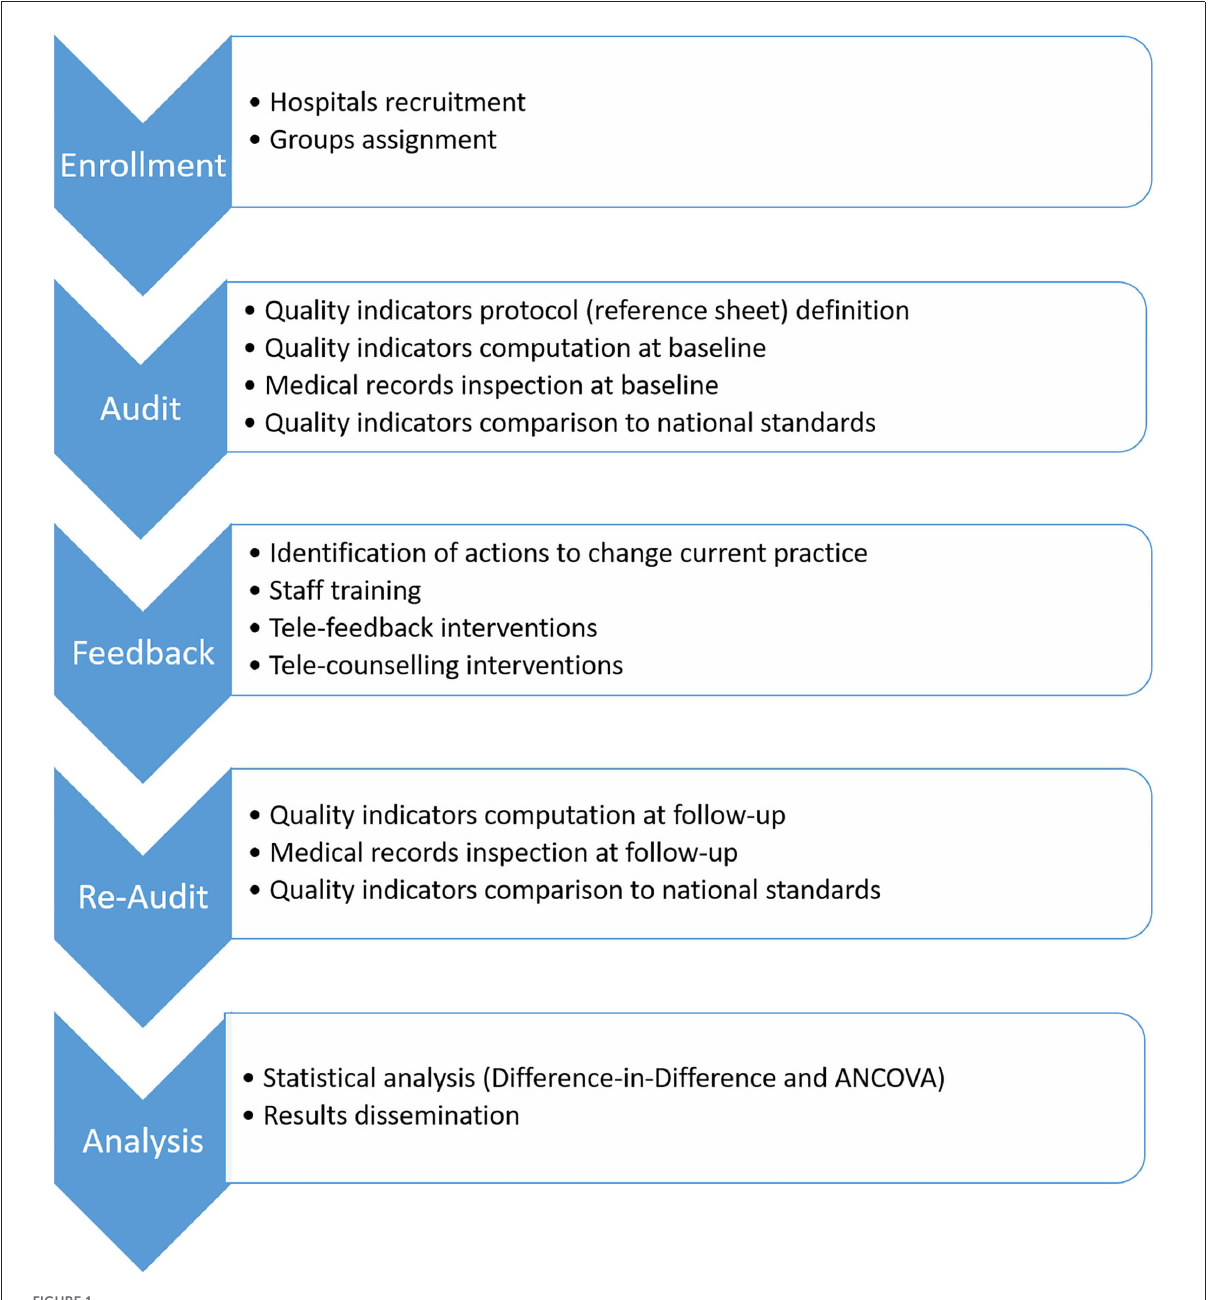
FIGURE1 Step-by-step project